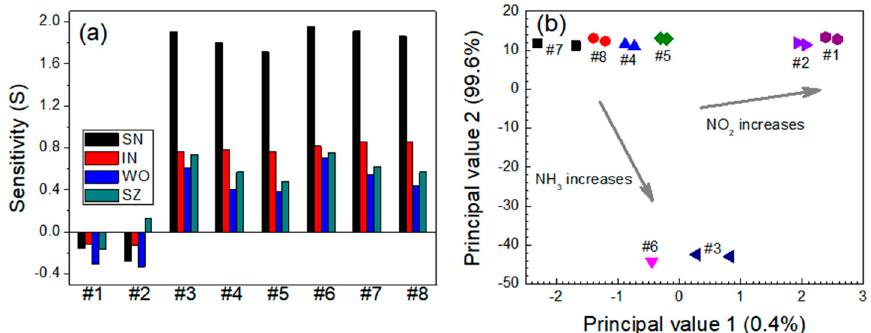
Figure 9. ( a ) Responses of the sensors and ( b ) PCA ‐ based dual ‐ gas sensor monitoring for the NO 2 ‐ NH 3 system. Note that #1–#8 represent 0.3 ppm NO 2 + 0 ppm NH 3 , 0.6 ppm NO 2 + 0 ppm NH 3 , 0 ppm NO 2 + 5 ppm NH 3 , 0.3 ppm NO 2 + 5 ppm NH 3 , 0.6 ppm NO 2 + 5 ppm NH 3 , 0 ppm NO 2 + 10 ppm NH 3 , 0.3 ppm NO 2 + 10 ppm NH 3 , and 0.6 ppm NO 2 + 10 ppm NH 3 , respectively.